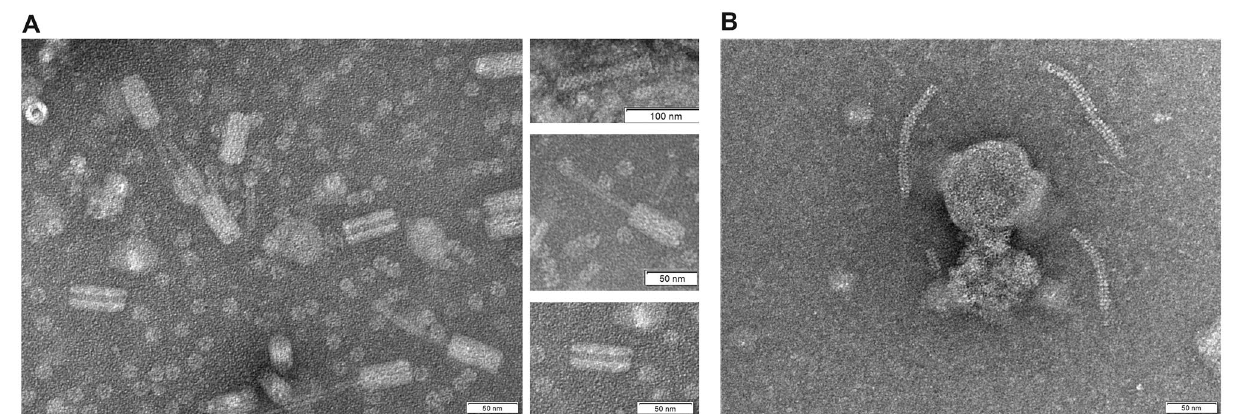
Figure 4. TEM images of pyocins. ( A ) R-type pyocin with a similar structure to a myovirus, in three conformations. Top: complete form; middle: contracted form; bottom: empty sheath of the pyocin. ( B ) F-type pyocin with a similar structure to a